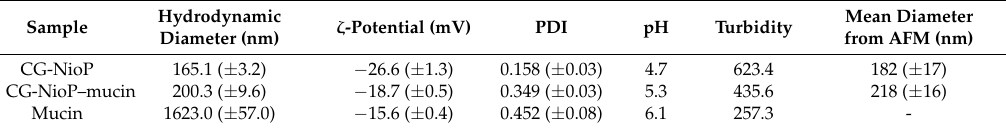
Table 6. Parameter measurements after CG-NioP contacted with mucin.